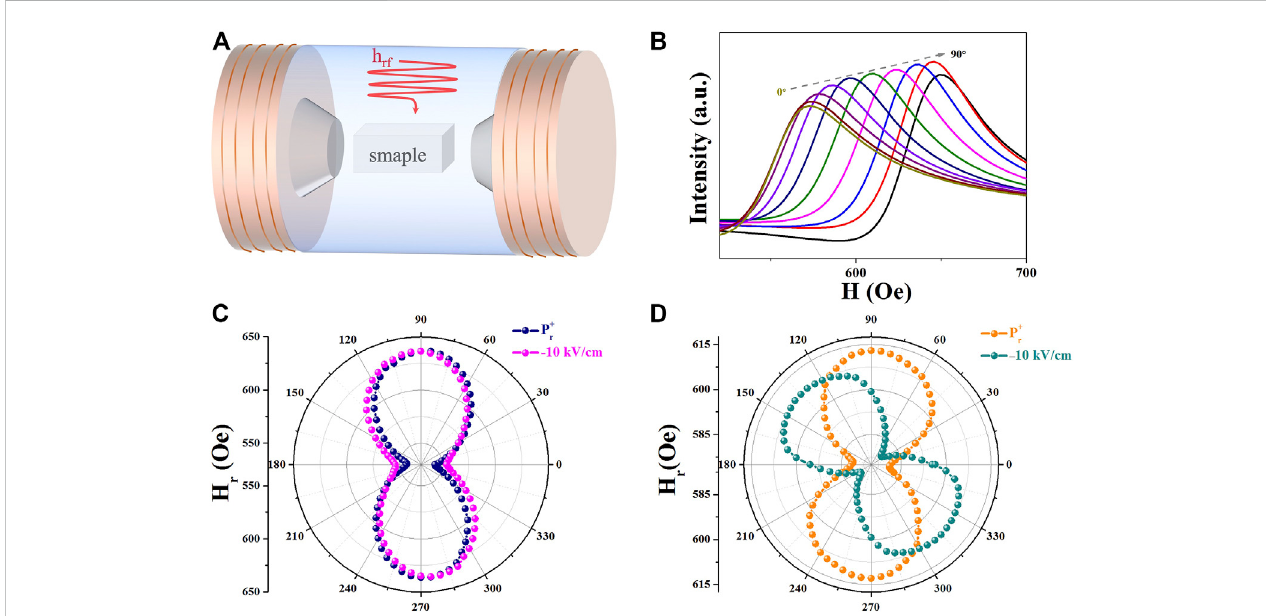
FIGURE 3 (A) Con fi gurationforFMR spectroscopy; (B) in-plane rotating-angleFMR integralspectra for theCoZr layeralongthe(01 – 1)PMN – PTsubstrate attheP 0 state; H r − φ curve under various electric fi elds for the CoZr layer along (C) (01 – 1) and (D) (100) of the PMN – PT